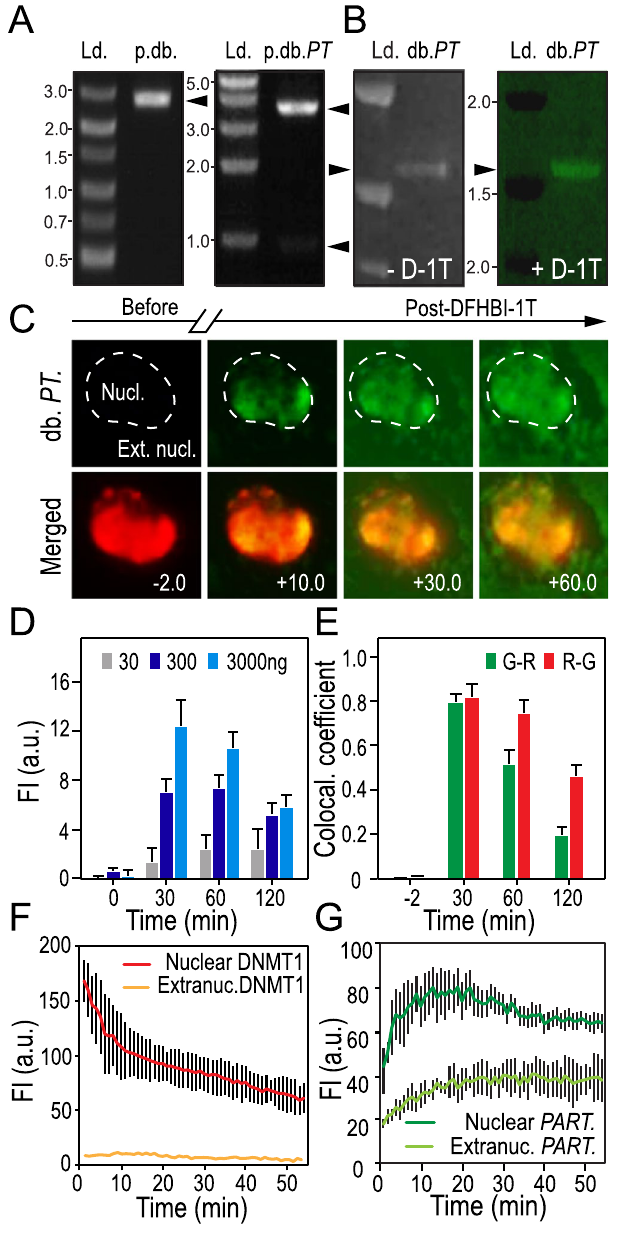
Figure 3. In vivo PARTICLE and DNA methyltransferase 1 (DNMT1) interaction. ( A ) Linearized dbroccoli in pUC57 (2956 bp; p.db.) after E coR I/H ind III restriction enzyme digestion resolved on a 1.8% agarose gel (left). Plasmid pGEM-T encoding dbroccoli - PARTICLE (p.db. PT ) restriction digested with N co I/H ind III to produce 3728 bp and 950 bp products (upper and lower arrows). DL3000 (Genscript) and Kb ladder (Ld. left and right gels respectively). ( B ) dbroccoli - PARTICLE (1678 bp; db. PT ) in vitro transcript resolved through a 12% NuPAGE gel alongside a high range RNA ladder (Ld. Thermo Fisher RiboRuler) before and after staining in DFHBI-1T ((Z)-4-(3,5-difluoro-4-hydroxybenzylidene)-2-methyl-1-(2,2,2-trifluoroethyl)-1 H -imidazol- 5(4 H )-one; left and right gels respectively). ( A,B ) Cropped images of gels shown. ( C ) Time-lapse fluorescence images of a U2OS cell transfected with db. PT and expressing a chromobody to DNMT1-V H H fused to TagRFP (DNMT1_RFP) before (minus time point) and after (plus time points) DFHBI-1T (20 μ M) addition. Scale bar 2 μ m. ( D ) Histograms of arbitrary units (AU) of overall fluorescence intensity with time in U2OS transfected with db. PT dose range in the presence of DFHBI-1T (20 μ M). Data are represented as mean ± SEM from n = 3 experiments per dose. ( E ) Summary co-localization plots for DNMT_RFP (ChR = red channel) and db. PT (ChG = green channel) from ROIs in the nucleus with time. Data are represented as mean ± SEM. ( F,G ) Plots of AU of fluorescence intensity with time from DNMT_RFP ( F ) and in db. PT ( G ) in ROIs (n = 10) within nuclear (encircling dashed line) and extranuclear (Extranuc.) cellular